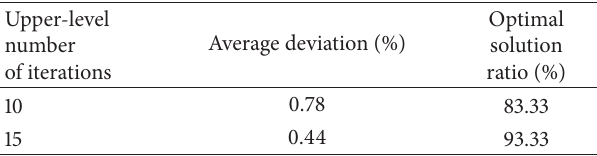
Figure 1: Gantt chart of the optimal solution. Table 1: Computing results vary from different number of iterations in the upper